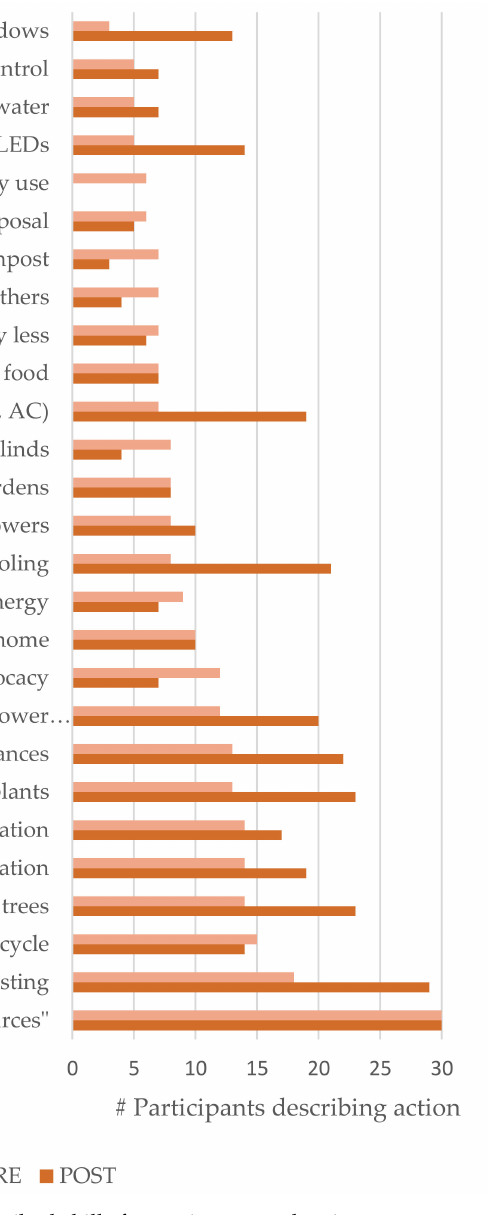
Figure 5. Most frequently described skills for environmental